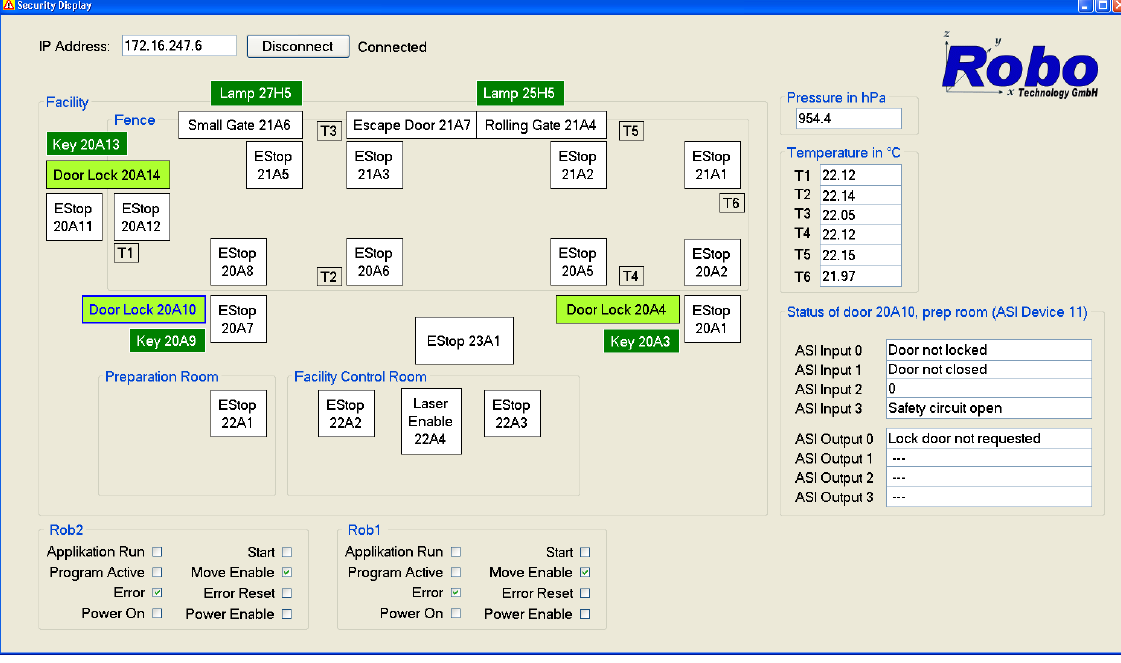
Figure 13: Security Display - Status of emergency stops, robots, doors, gates and